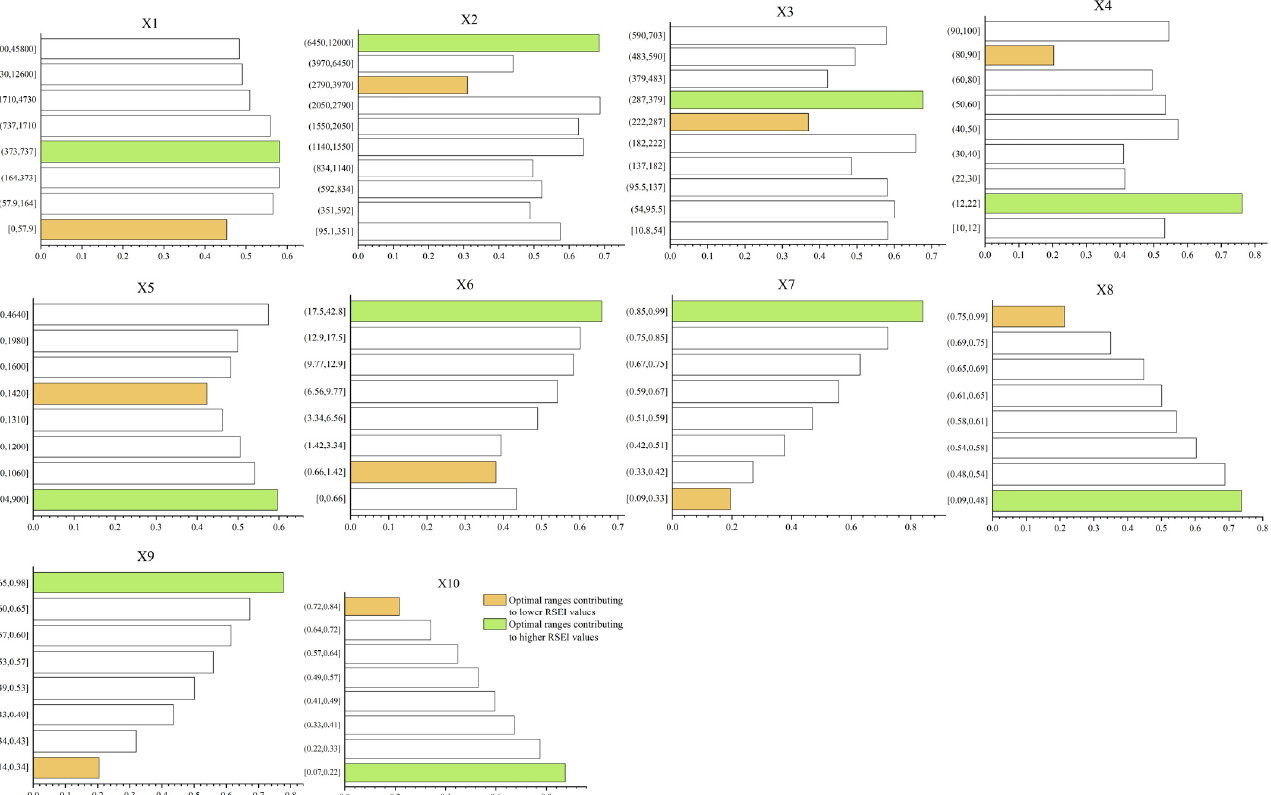
Figure 11. Optimal ranges and tipping points of drivers influencing RSEI. Note: X1–X10 same as in Table 2.